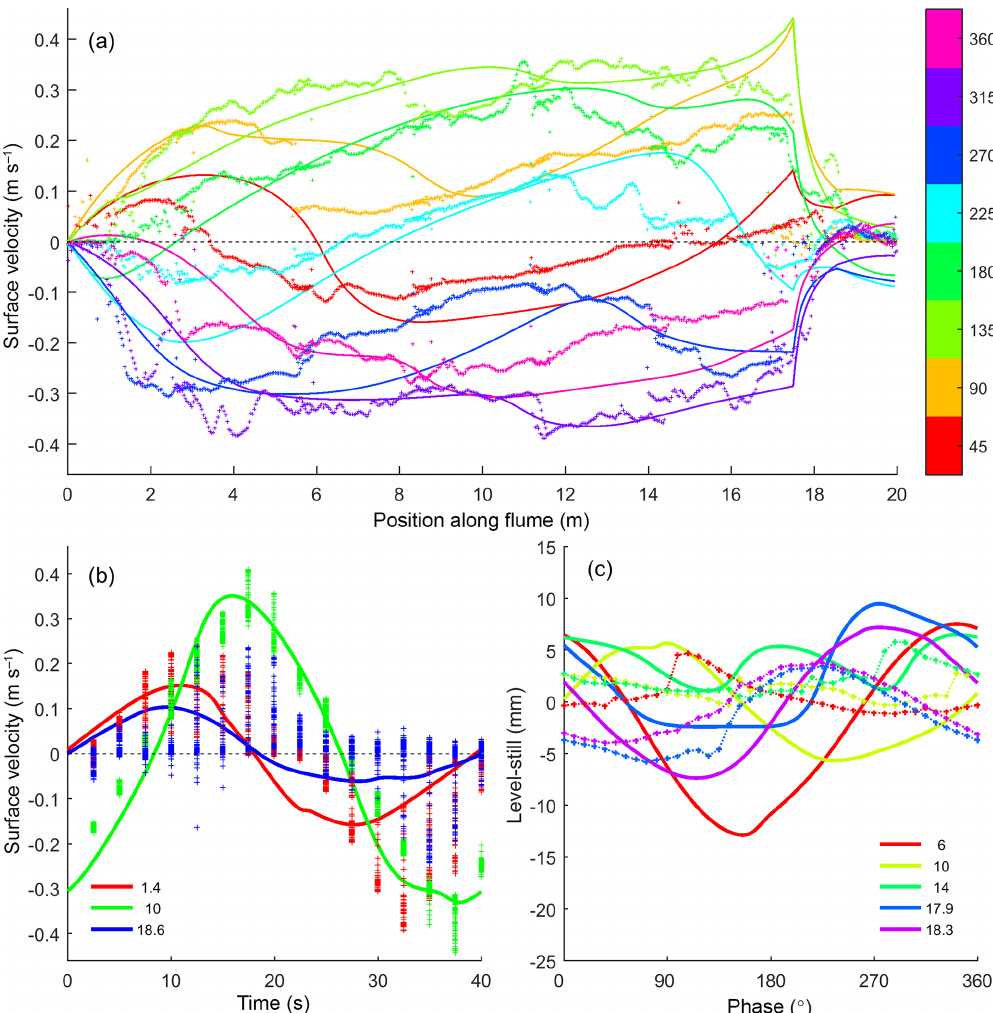
Figure 13. Flow data in an 18m sand-bed channel with a 2m long by 3m wide sea from PIV and modelled flow with 40s period tilting at 0.004mm − 1 slope amplitude with the landward boundary closed. (a) Flow velocity at the water surface along the flume for selected phases of the tidal cycle. (b) Flow velocity at the water surface in one tidal cycle for selected positions along the flume measured from x = 0m, indicated in the legend. (c) Water level measured by acoustics as a function of phase in the tidal cycle for selected positions along the flume. Data are plotted as symbols and model results are plotted as drawn